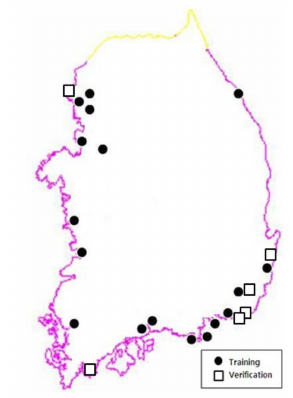
Figure 4. Seventeen local sites for this